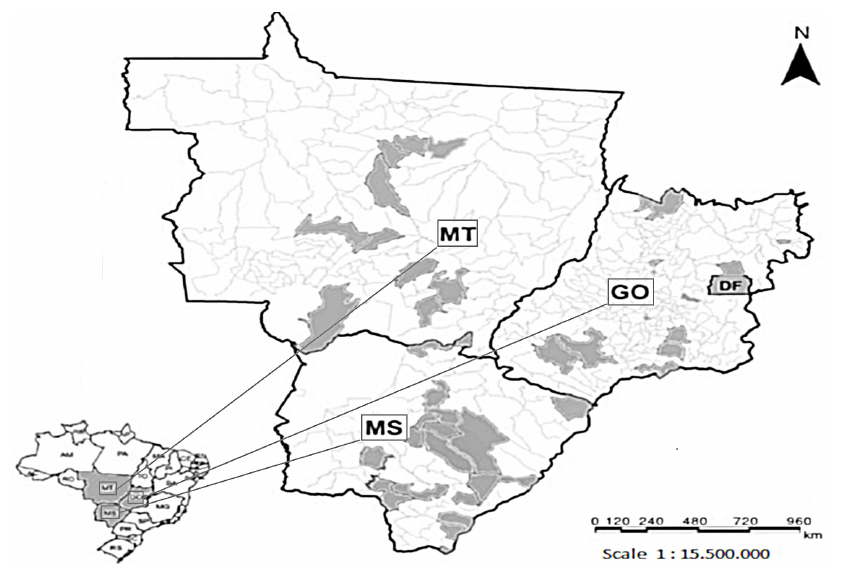
Figure 1. Municipalities of settlements surveyed in the Brazilian